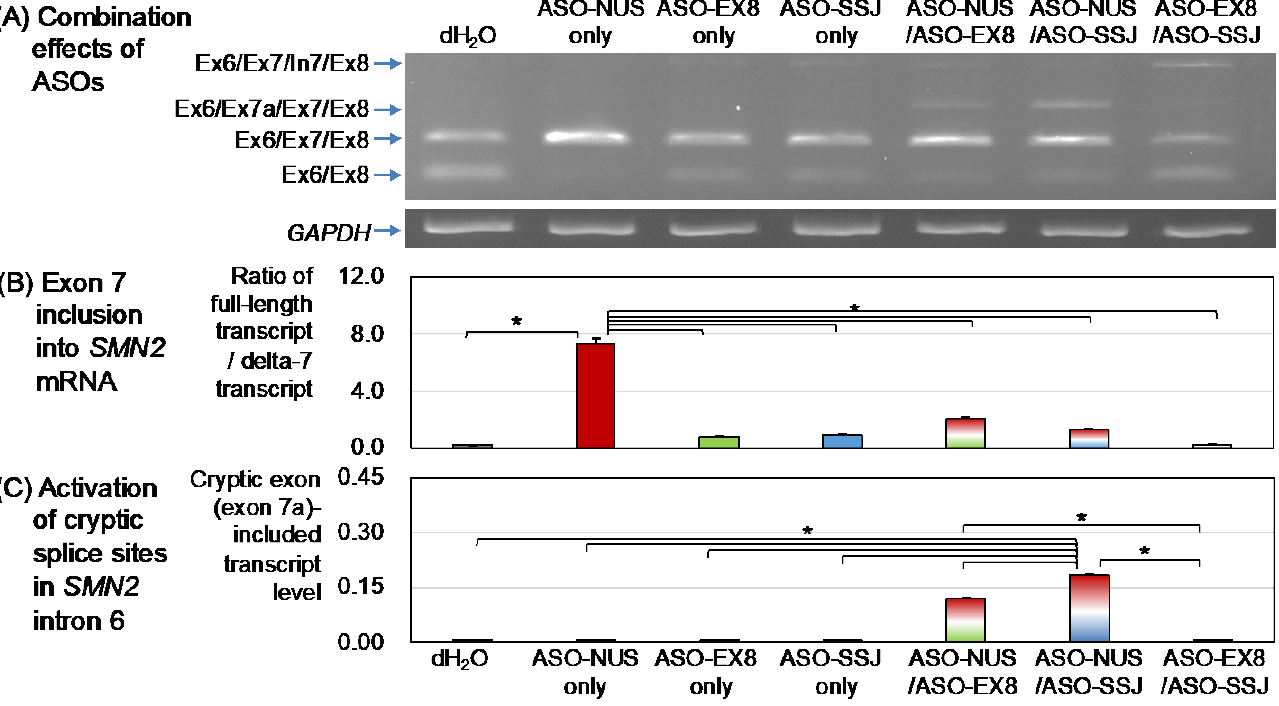
Figure 4. The effects of ASOs combination in SMA fibroblast. ( A ) Agarose gel electrophoresis of RT-PCR analysis. Combinations of two ASOs, each at a concentration of 100 nM (total 200 nM), were used in this study. Lane 1 is control cells transfected with dH 2 O. Lanes 2-4 are control cells with a single ASO (100 nM). The arrows indicate the transcript product of SMN2 (upper panel) or GAPDH (lower panel). ( B ) Quantification of exon 7 inclusion into SMN2 mRNA determined from the RFD. ( C ) Quantification of exon 7a into SMN2 mRNA. An asterisk (*) indicates p < 0.01 in ANOVA.